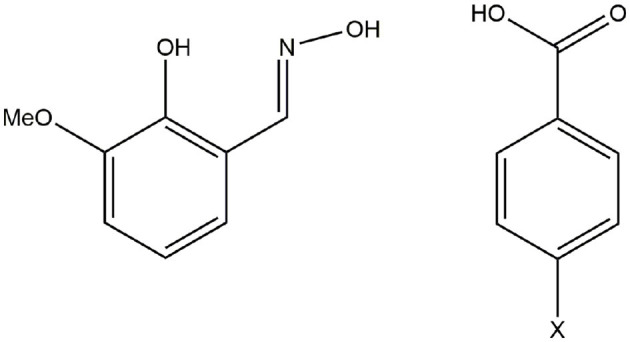
H2vanox (left) and 4-parasubstituted benzoic acid (right).